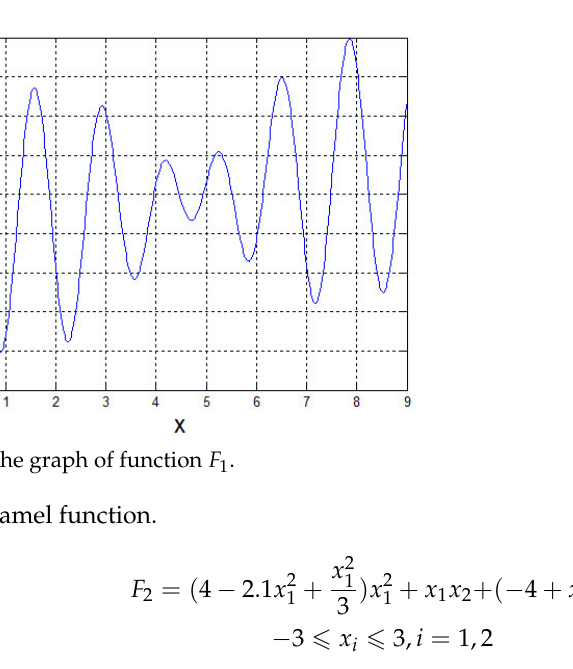
Figure 4. The adaptive adjustment curve of P m .